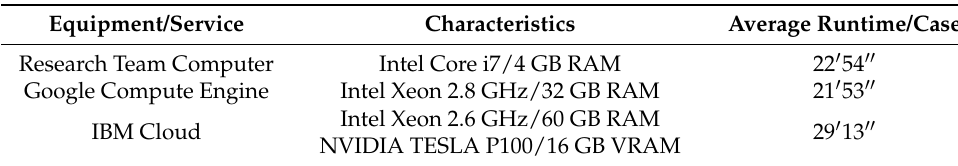
Table 2. Comparative results of the preliminary testing process.